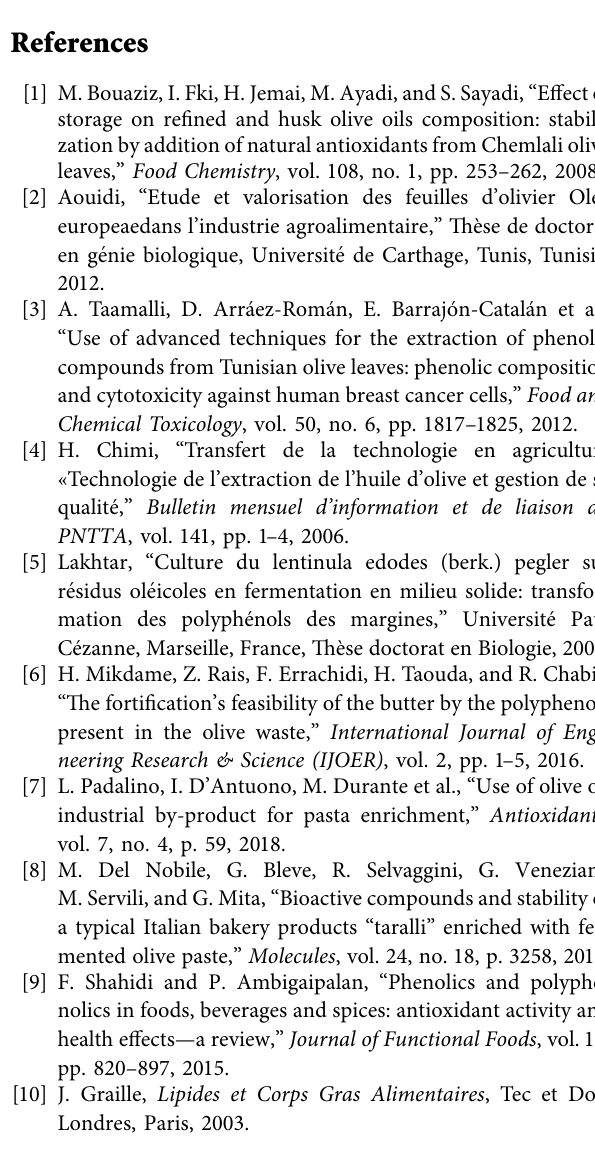
Figure 10: Evolution of yeast and mold populations of butters as a function of time. (a) Samples stored at 25 ° C. (b) Samples stored at 60 °